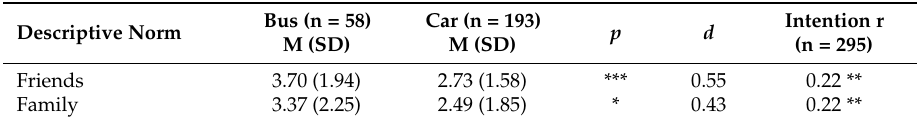
Table 7. Descriptive norm for a journey by bus. Mean, SDs, Cohen’s d for either bus users or car drivers and Pearson’s correlation with intention.